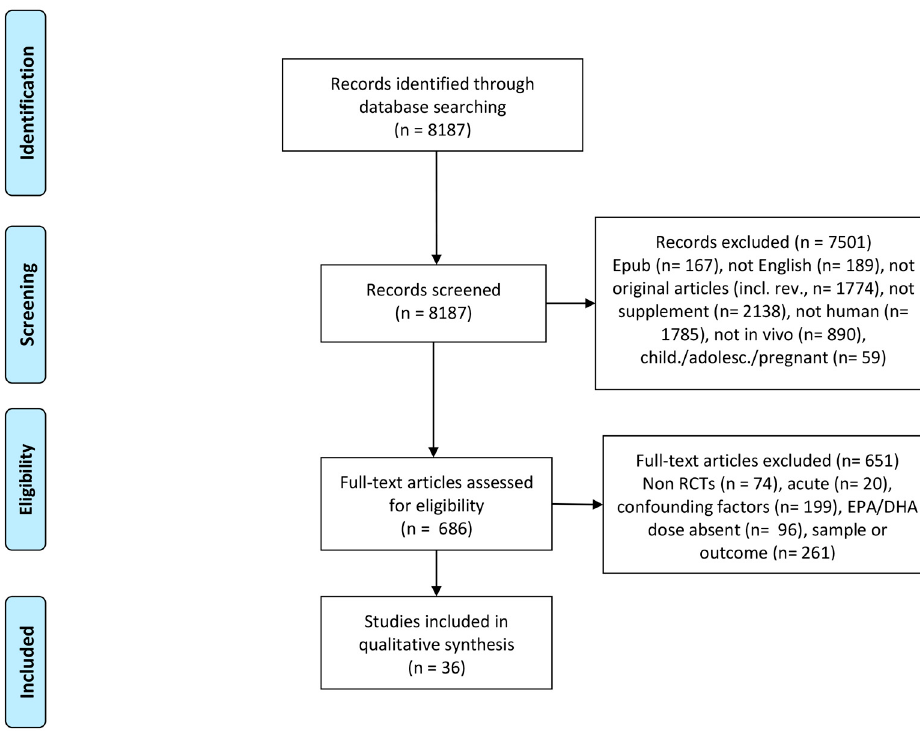
Figure 1. PRISMA 2009 Flow Diagram for search of literature and assessment of eligibility for studies included in the review. A total of 8187 records were identified and screened, among which 36 papers were included in qualitative synthesis and presented.